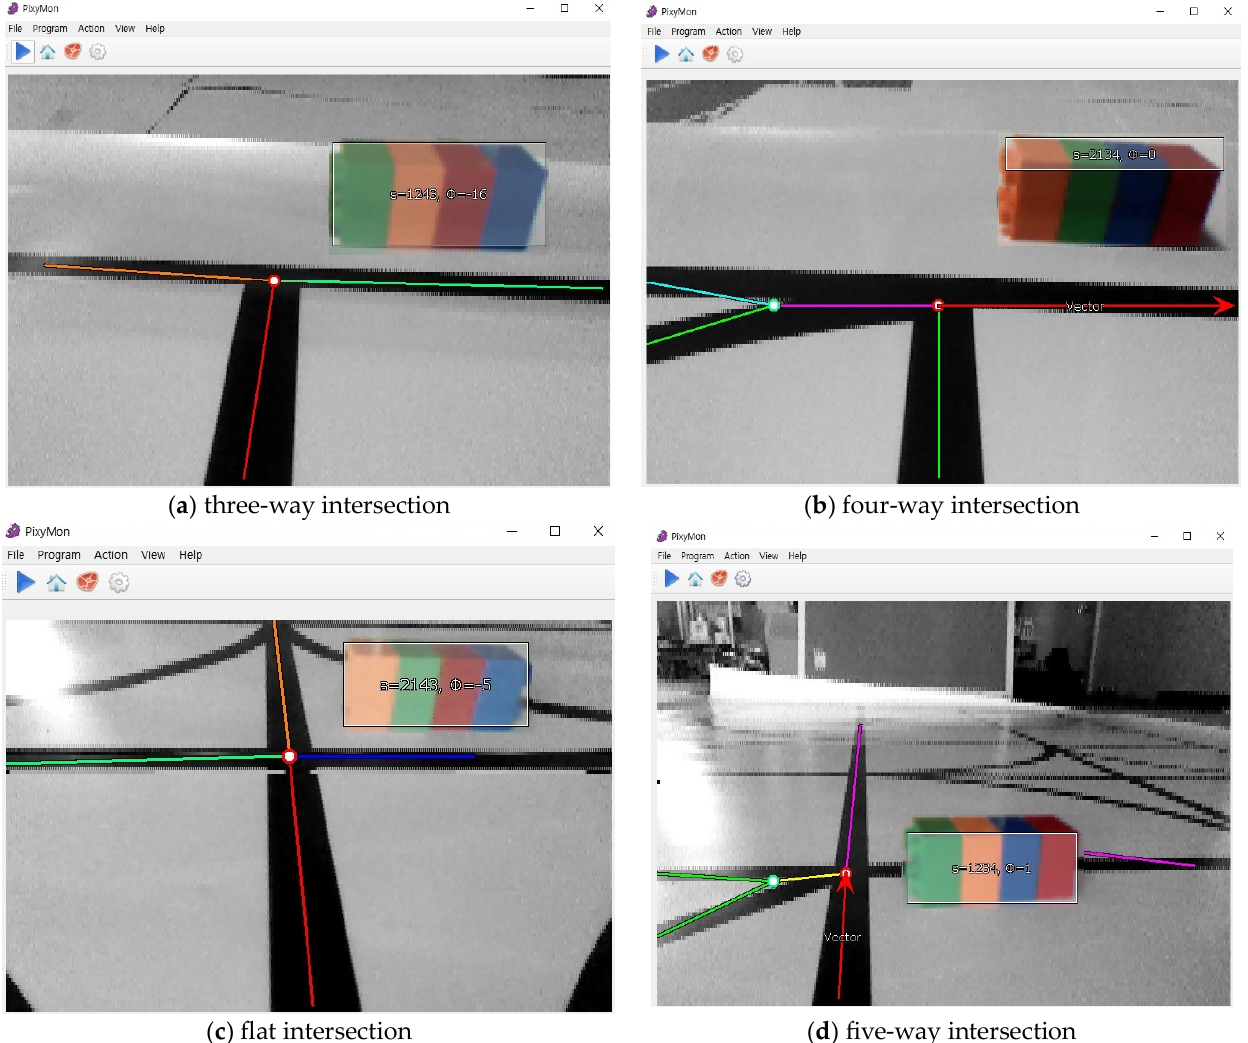
Figure 9. Experimental result of the driving algorithm of the AGVA-Robot.